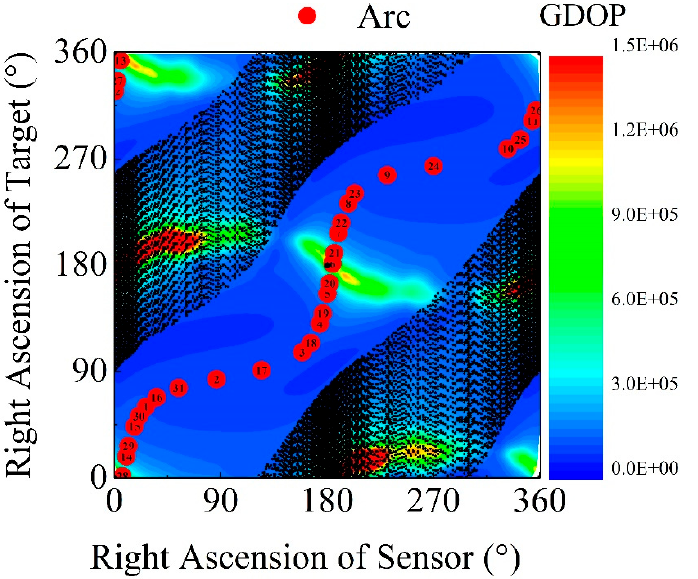
Figure 5. Right ascension of the target and optical sensor in the new coordinate system, which corresponds to the midpoint of each visible arc segment.